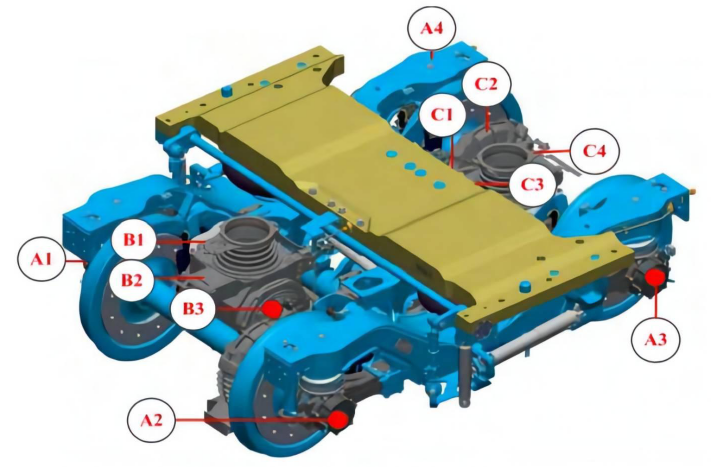
Figure 1. Structure of a running gears